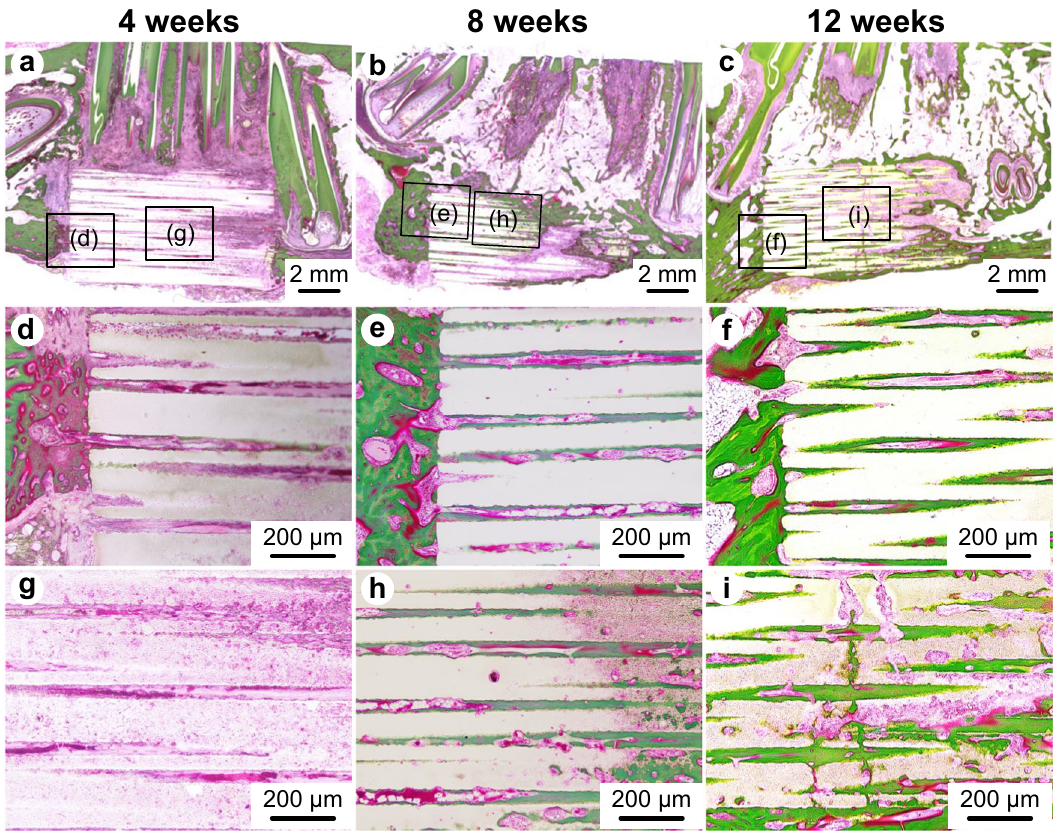
Fig. 7 Typical histological images resulting from Villanueva Goldner staining of CO 3 Ap HCBs. At 4 ( a , d , g ), 8 ( b , e , h ), and 12 weeks ( c , f , i ) after